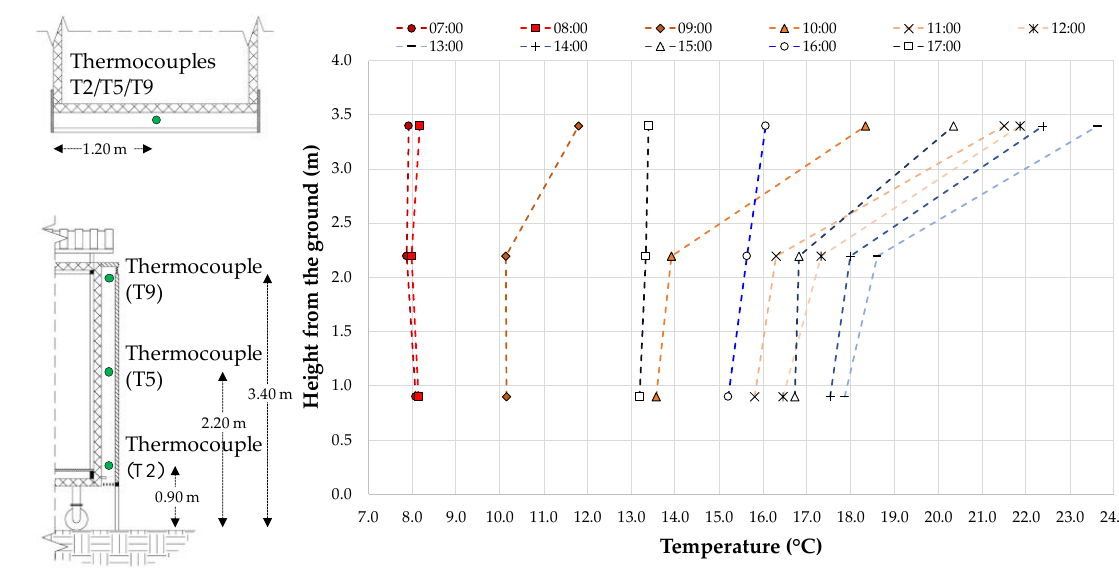
Figure 7. Daily values of the cavity air temperature.